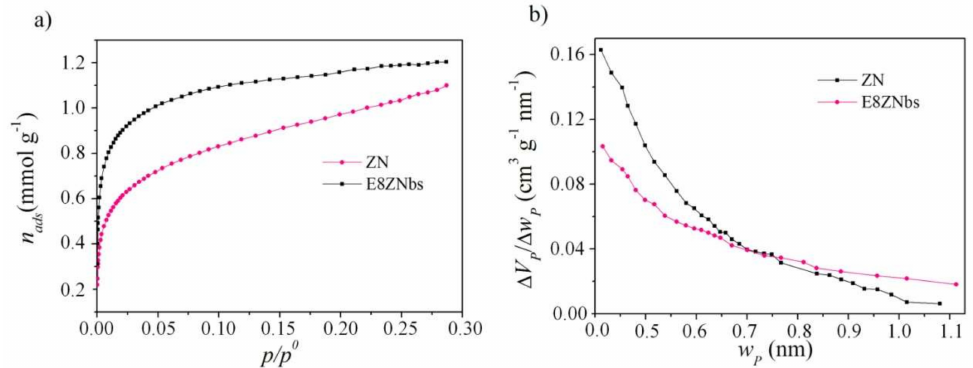
Figure 8. Characterization of micropores. ( a ) CO 2 adsorption isotherm at 273 K and ( b ) micropore size distribution by HK